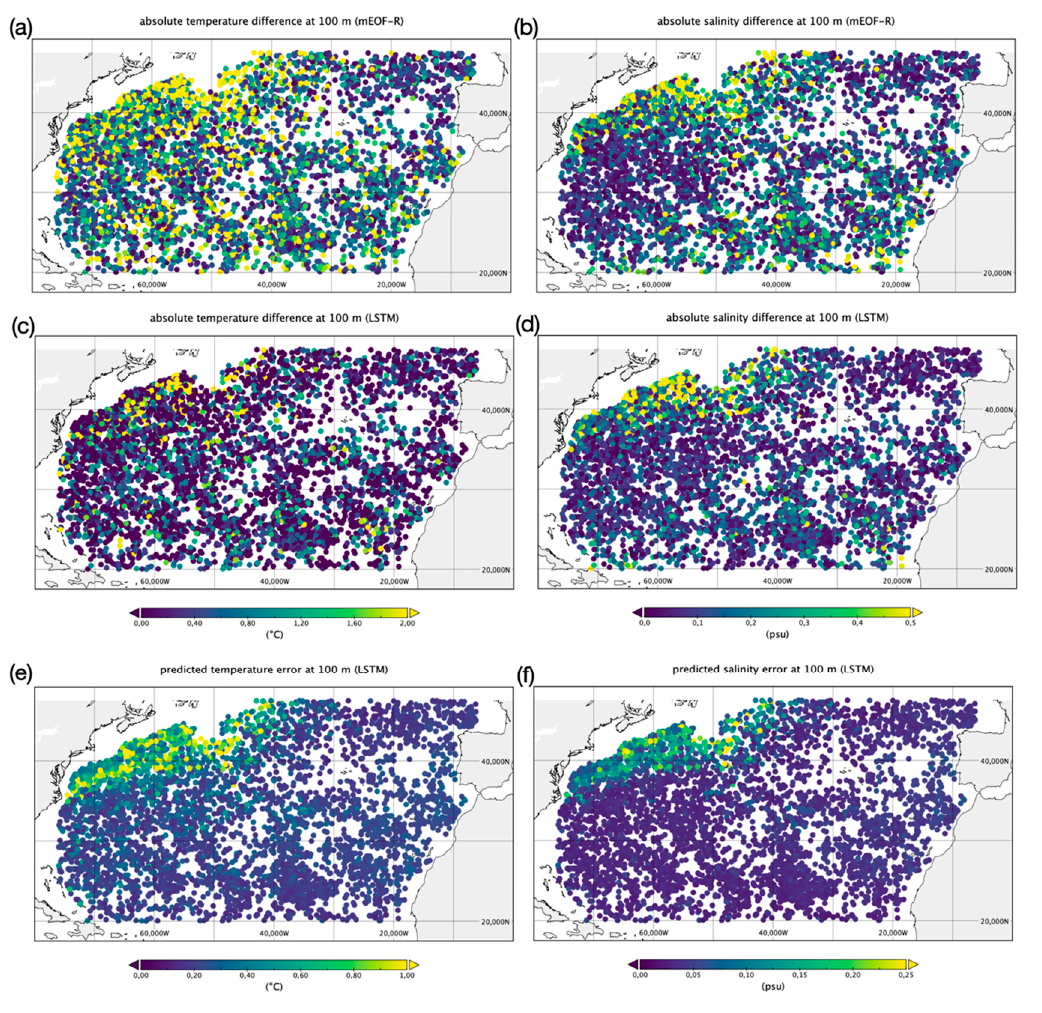
Figure 4. Absolute value of the di ff erences between mEOF-r temperature ( a ) and salinity ( b ) and observed test data at 100 m depth, and corresponding LSTM (35–35) di ff erences ( c , d ). Temperature ( e ) and salinity ( f ) predicted LSTM (35–35) reconstruction error at 100 m.